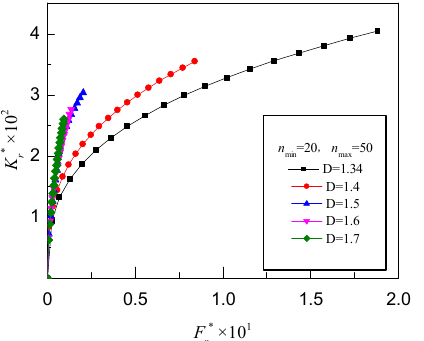
∗ K and fractal dimension D . Figure 6. Relation between dimensionless normal stiffness K r and fractal dimension D r K and fractal dimension D . r